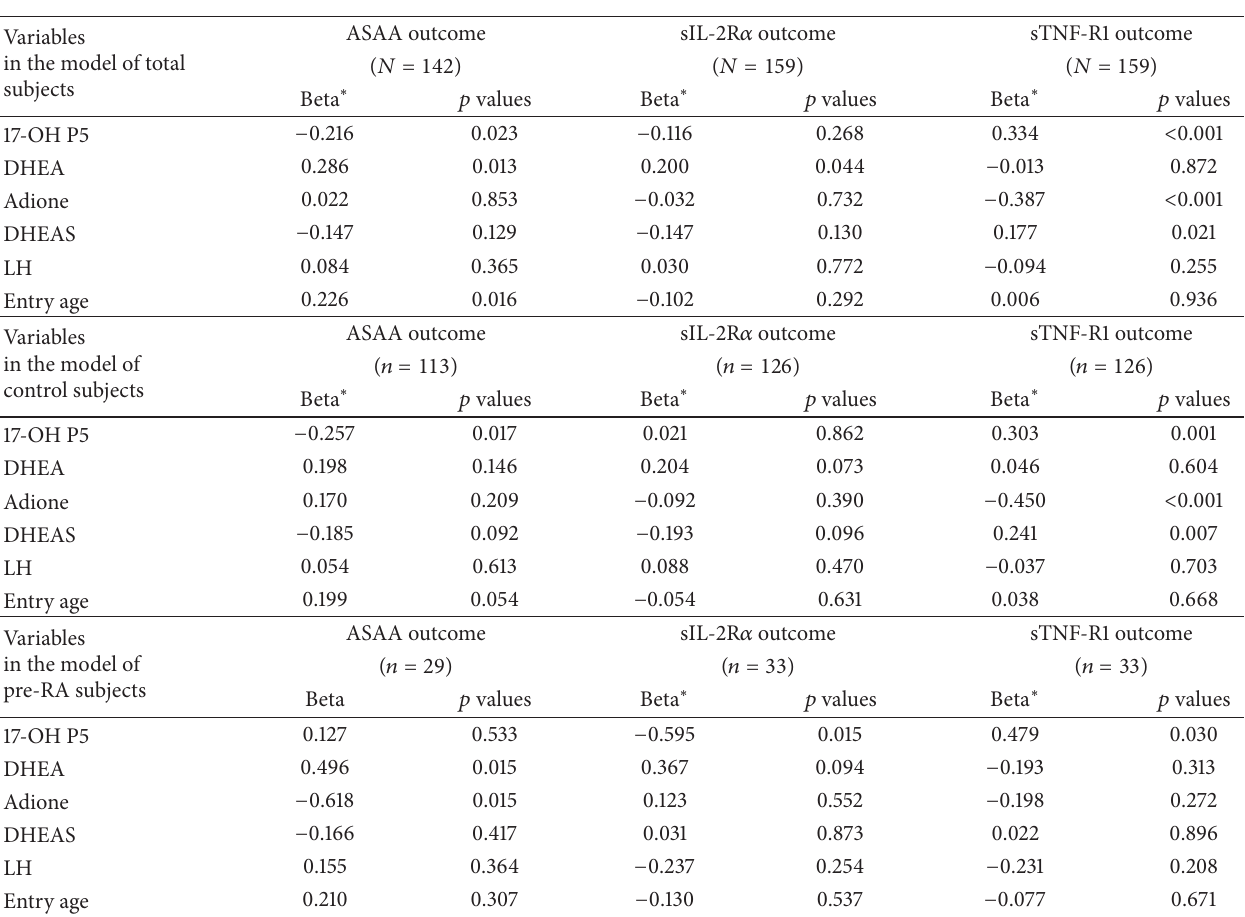
Table 5: Multiple regression models of serum inflammatory biomarker outcomes including steroidal and hormonal variables that had predicted